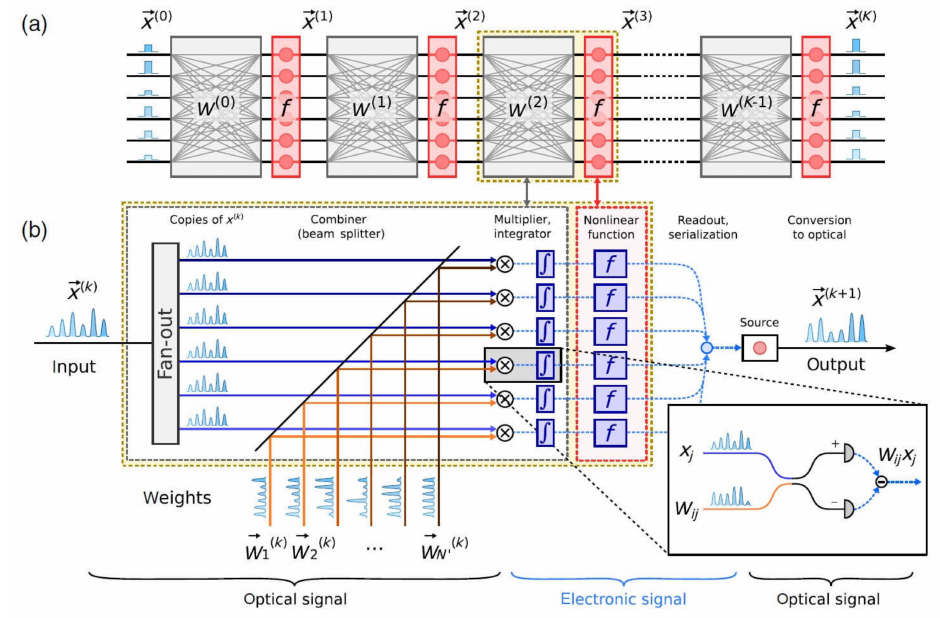
Figure 8. ( a ) Schematic diagram NN of K-layers consisting of a multiplier (grey) and an element for the activation function (red). ( b ) The multiplication performs a combination of inputs with the weight signals using homodyning [73].